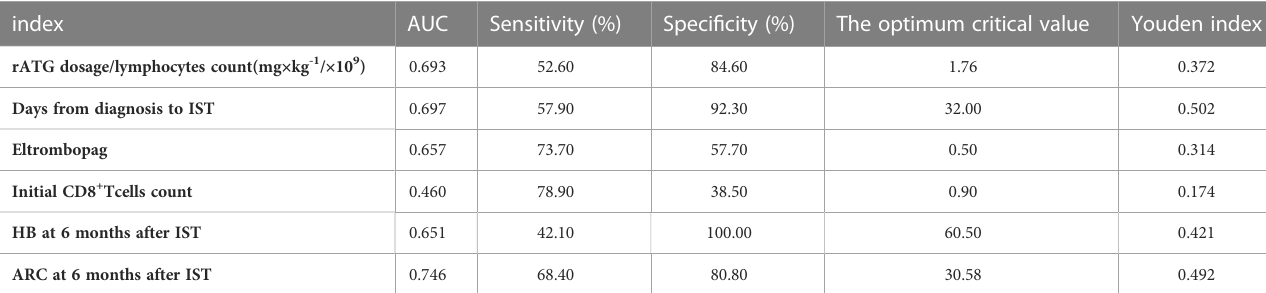
TABLE 4 Prediction performance of the ROC analysis